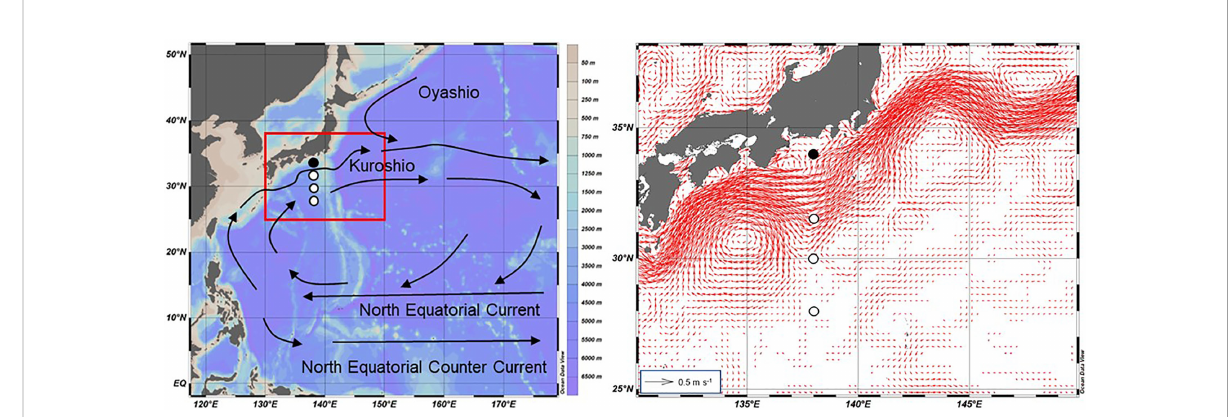
FIGURE 1 Sampling locations and main ocean currents in the western North Paci fi c (left). Sediment trap experiments were conducted shoreward (slope: closed circle) and on the oceanic side (subtropical gyre: open circles) of the Kuroshio Current. Right panel corresponds to the area indicated with red square in the left panel. Red arrows in the right panel indicate the mean surface geostrophic current calculated from daily surface geostrophic current data with a horizontal resolution of 0.25° from 1 August 2013 to 30 November 2019 (EU Copernicus Marine Service: https:// www.marine.copernicus.eu). Detailed information about each station and the location of the Kuroshio Current axis relative to 138°E during each sampling period are provided in Table 2. The map was drawn using Ocean Data View (http://odv.awi.de/).